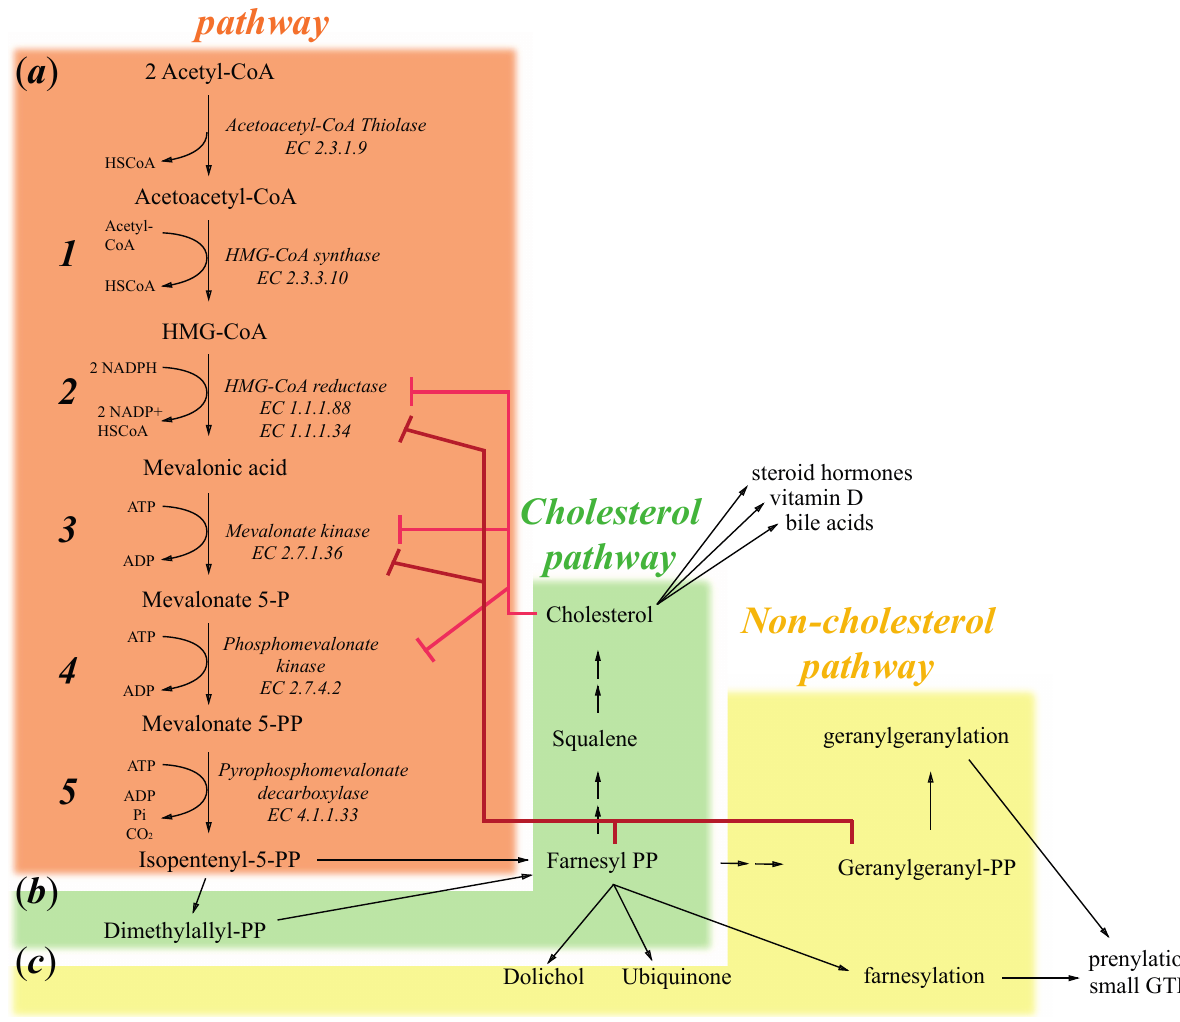
Figure 1. Schematic representation of the mevalonate pathway divided into: ( a ) The mevalonate pathway that produces mevalonate 5-PP and then isppententenyl 5-PP; ( b ) The cholesterol pathway that produces cholesterol, which in turn induces the formation of steroid hormones, vitamin D and bile acids; and ( c ) The non-cholesterol pathway important for the production of farnesyl-PP and geranylgeranyl-PP that induces respectively farnesylation and geranylgeranylation of small